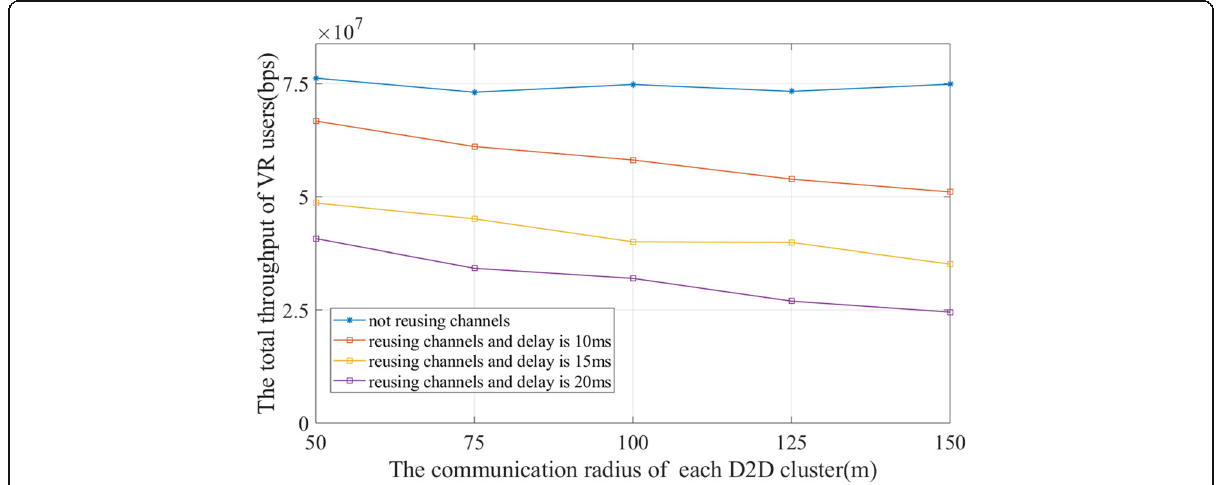
Fig. 7 The influence of the radius size of D2D clusters on the total throughput of VR users